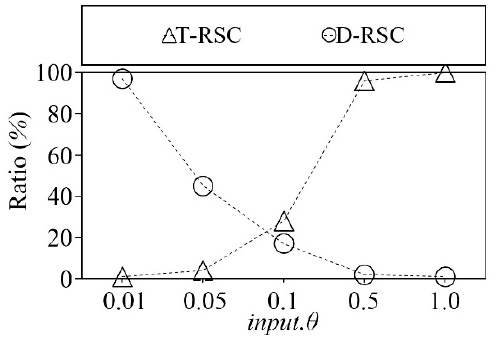
Figure 19. Ratio of RSC result on real dataset with varied input. θ .